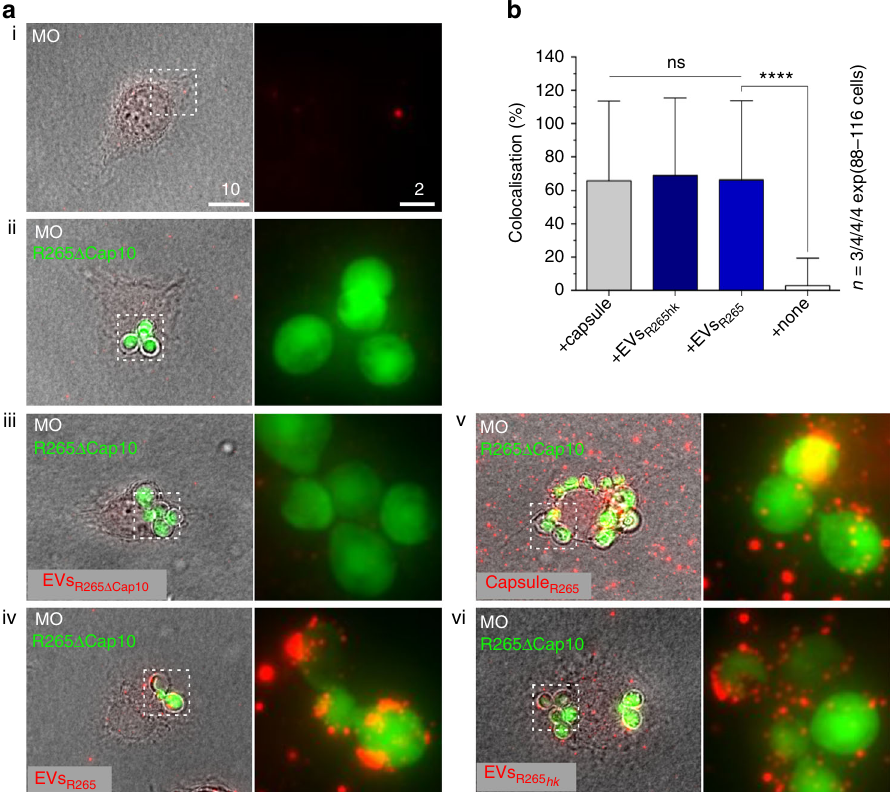
Fig. 6 EVs added to macrophages infected with acapsular R265-GFP rapidly colocalise with the cryptococcal phagosome. a Macrophages alone (MO; i), macrophages with phagocytosed R265 Δ Cap10-GFP cells (ii) or macrophages containing R265 Δ Cap10-GFP and co-incubated with EVs isolated from R265 Δ Cap10 (EVs R265 Δ Cap10 ; (iii)) are not recognised by capsule-speci fi c MAb 18B7. Those macrophages co-incubated with EVs isolated from R265 (EVs R265 ; (iv)), with capsule isolated from R265 (Capsule R265 ; (v)) or heat-inactivated EVs isolated from R265 (EVs R265 hk ; (vi)) show colocalisation between R265 Δ Cap10-GFP cells and red signal suggesting that the EVs and capsule polysaccharides were delivered to the phagosomes. Pictures represent maximum intensity projections of 21 z-stacks obtained from 10 μ m cross section through macrophages. Bars: 10 and 2 μ m. b Graph showing percentage of colocalised signals of GFP labelled yeast cells R265 Δ Cap10 engulfed by murine macrophages and MAb 18B7-immunostained capsule ( + capsule), heat- inactivated EVs isolated from R265 (EVs R265 hk ) or EVs isolated from R265 ( + EVs R265 ). As a negative control intensities from macrophages infected with R265 Δ Cap10-GFP without EVs were used ( + none). All numbers are given as means ± standard deviation (s.d.) and are representative of results from 3